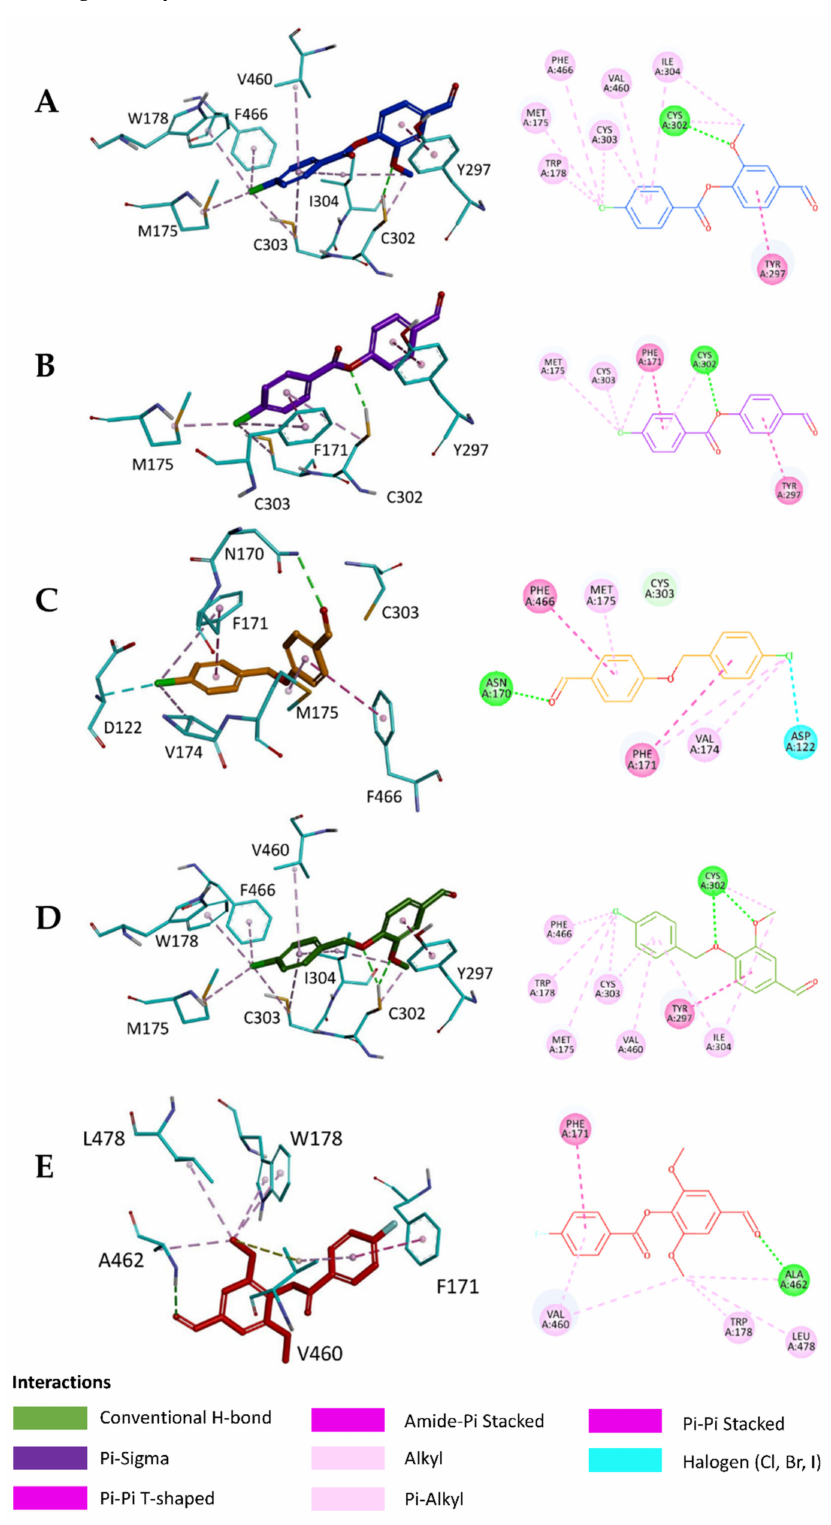
Figure 4. Molecular docking of: ( A ) ABMM-1 (blue), ( B ) ABMM-2 (purple), ( C ) ABMM-15 (orange), ( D ) ABMM-16 (green) and ( E ) ABMM-18 (red) into the ALDH1A1 binding site (cyan-colored